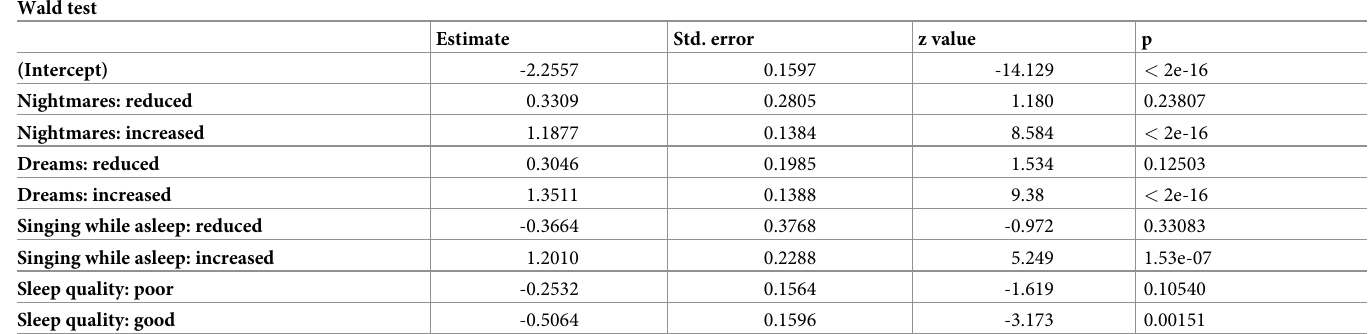
Table 3. The Wald test for the coefficients embodying the logistic regression model to account for the influence of sleep events on the probability of an increased frequency of lucid dreams during the pandemic. For every predictor, the neutral level was used as a reference. Wald test